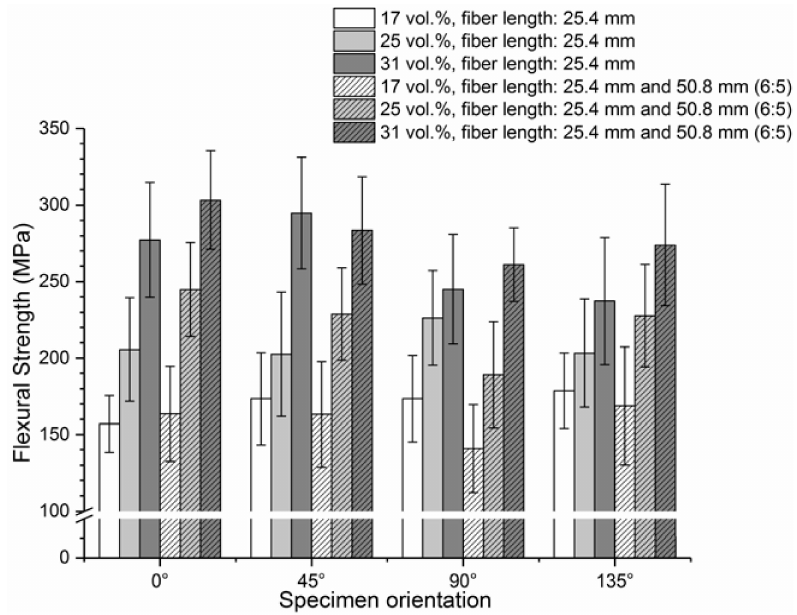
Figure 7. Flexural strength of different SMC materials in different directions with respect to the movement of the conveyor